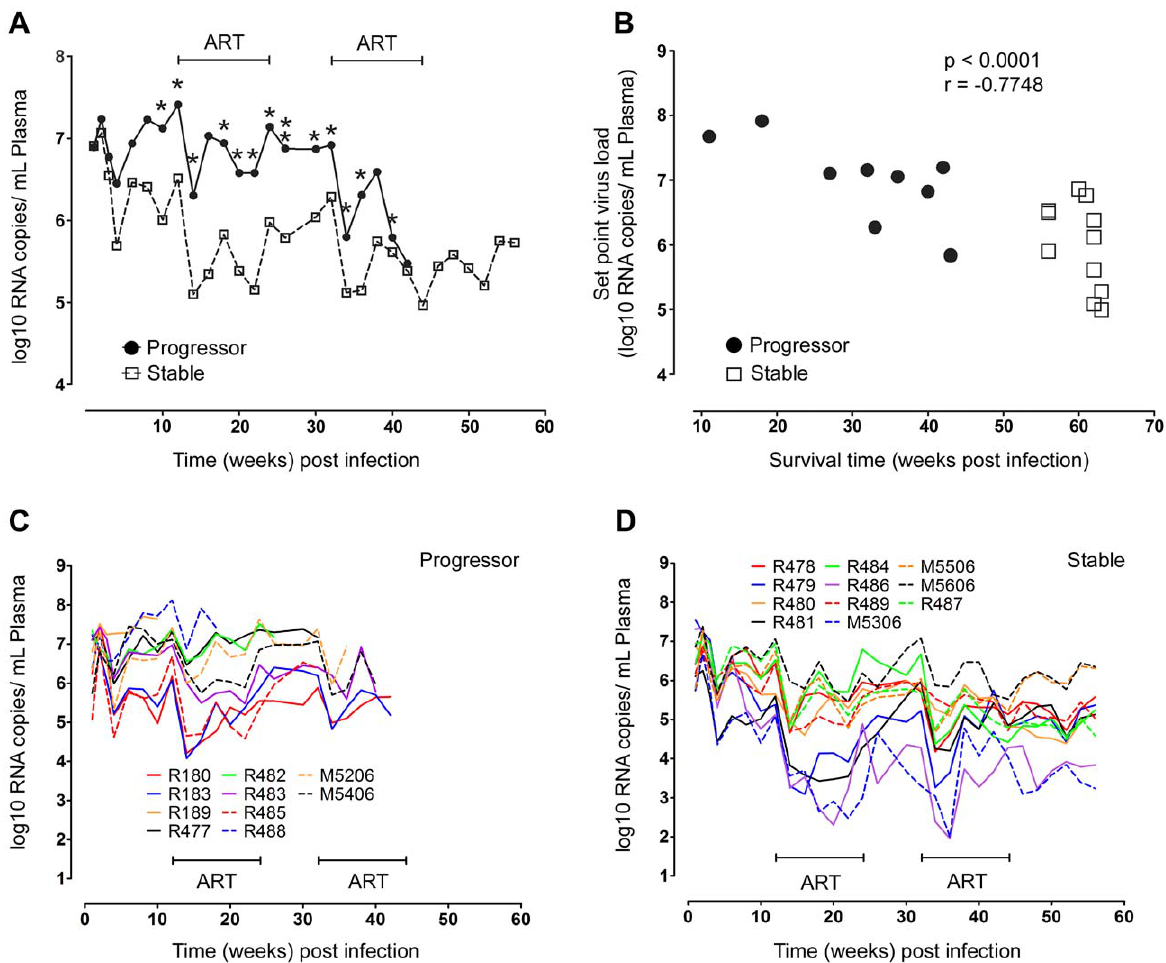
Figure 1. Relationship between virus load and disease progression in SIV infected macaques. (A) Mean virus load in plasma for SIV- infected animals that progress rapidly to disease (progressor, n=10) or remain disease free for more than one year (stable, n=11). * P , 0.05, ** P , 0.01 (week 26). (B) Correlation between survival time and virus load at set-point, taken as the mean virus load from weeks 8 to 12 post infection, for all animals. Data points for animals R180 and R183, which died at week 43 with very similar virus loads, appear as a single data point. (C, D) Individual virus load measurements for progressor (C) and stable animals (D). ART=intervals of antiretroviral therapy.